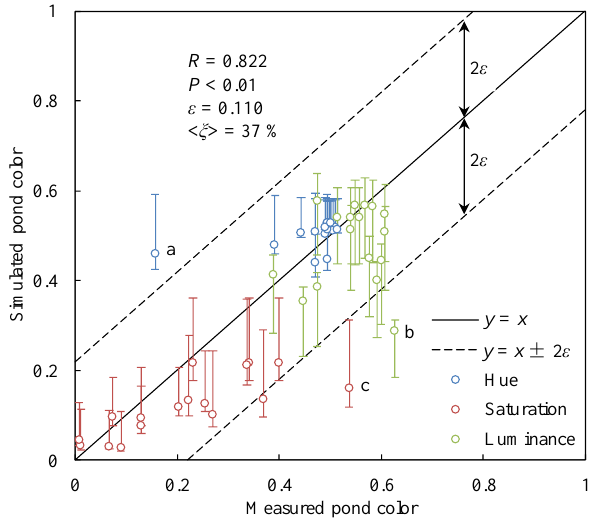
Figure 9. Comparisons of simulated pond color with in situ mea- surements by Istomina et al. (2016) in the HSL color space. Points a, b, and c are special cases discussed in the text. The vertical error bars on the simulated color denote the uncertainties due to varia- tions in the incident solar radiation and ice scattering coefficient different from their default values. R is the correlation coefficient between simulated and measured color. P is the significance level of the correlation. ε is the root-mean-square error, and <ξ > is the mean of relative error in simulated